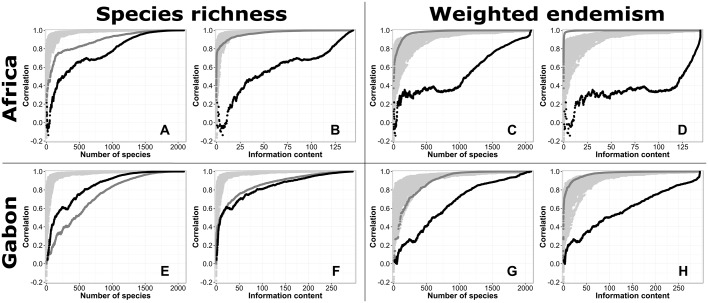
Correlations between subset and total diversity patterns.Correlations are presented between species richness patterns based on subsets of n Gabonese plant species (n_richness) and total Gabonese species richness (A,B,E,F), as well as between weighted endemism patterns based on subsets (n_weighted_endemism) and total weighted endemism (C,D,G,H). Subsets were composed along the narrow-ranged to widespread sequence (dark grey lines), widespread to narrow-ranged sequence (black lines), and 100 random sequences (light grey lines). Defining the species sequences was done on the prevalences of species in either tropical Africa (A-D), or Gabon (E-H). Correlations are plotted against the number of species (A,C,E,G) or the information content of the subset (B,D,F,H).